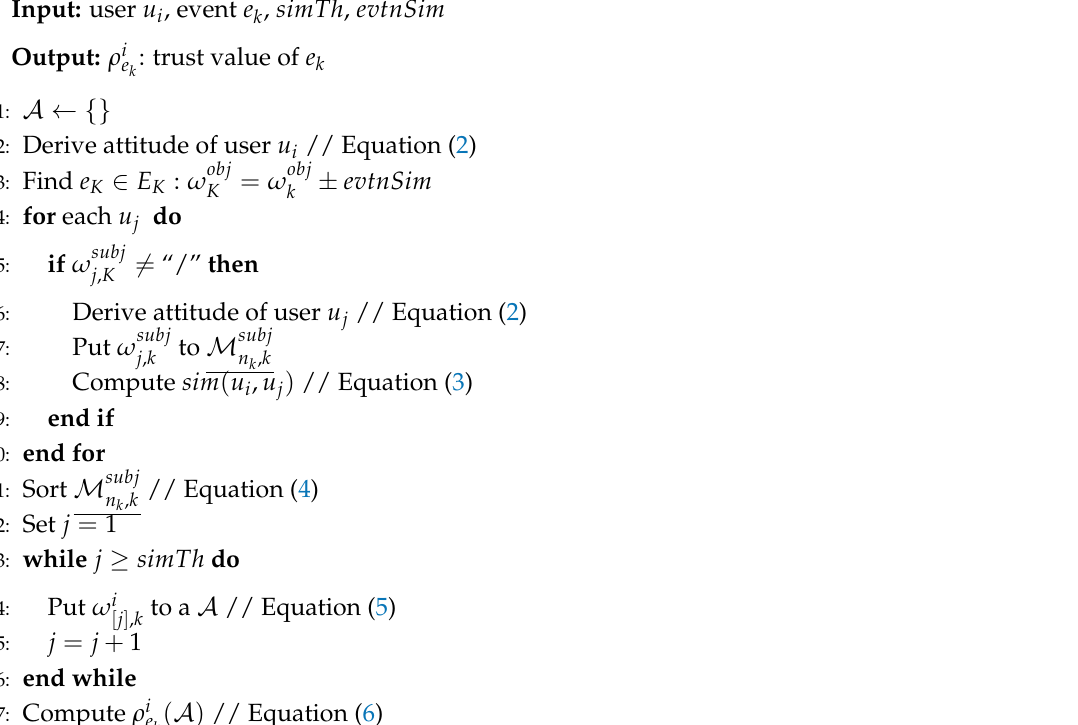
Algorithm 1 Method for computing a trust value of an